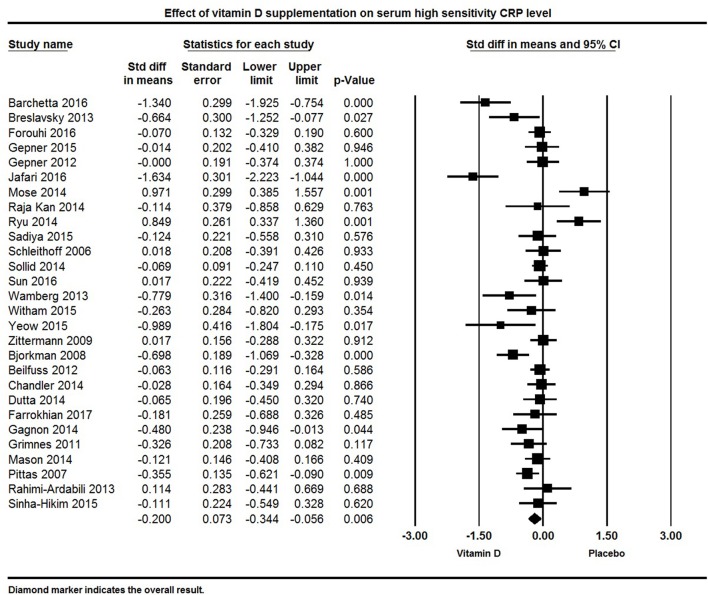
Forest plot detailing standardized mean difference for the impact of vitamin D on serum high sensitivity CRP level.